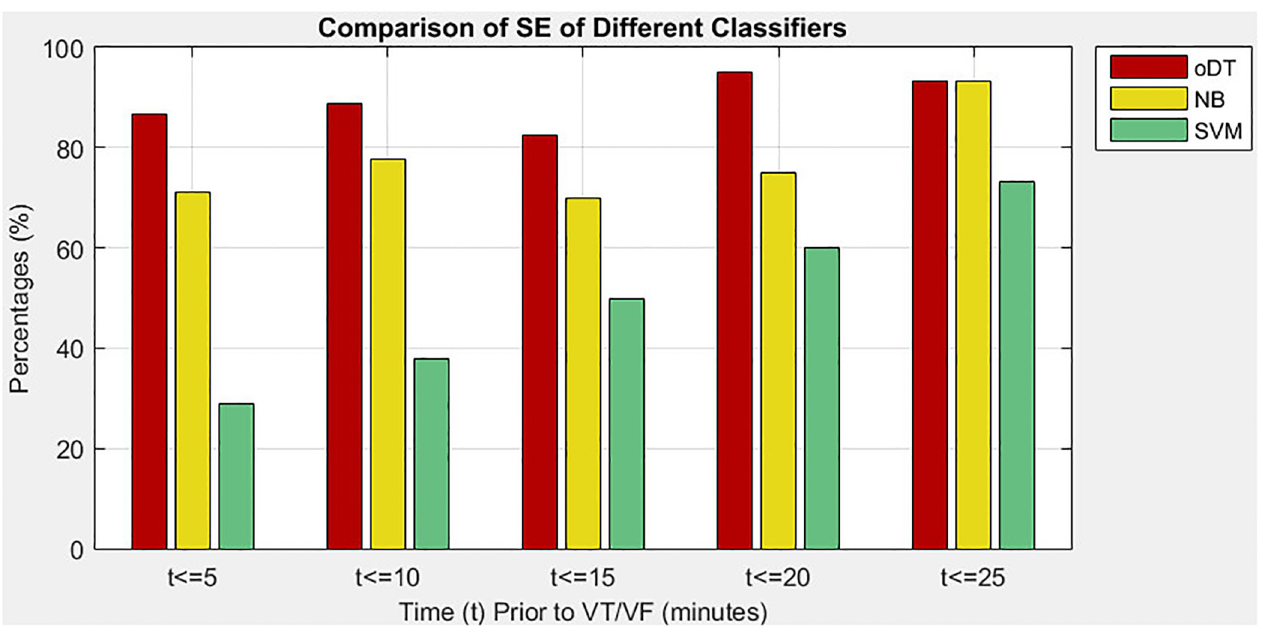
Fig 6. Comparison of SE among oDT, NB and